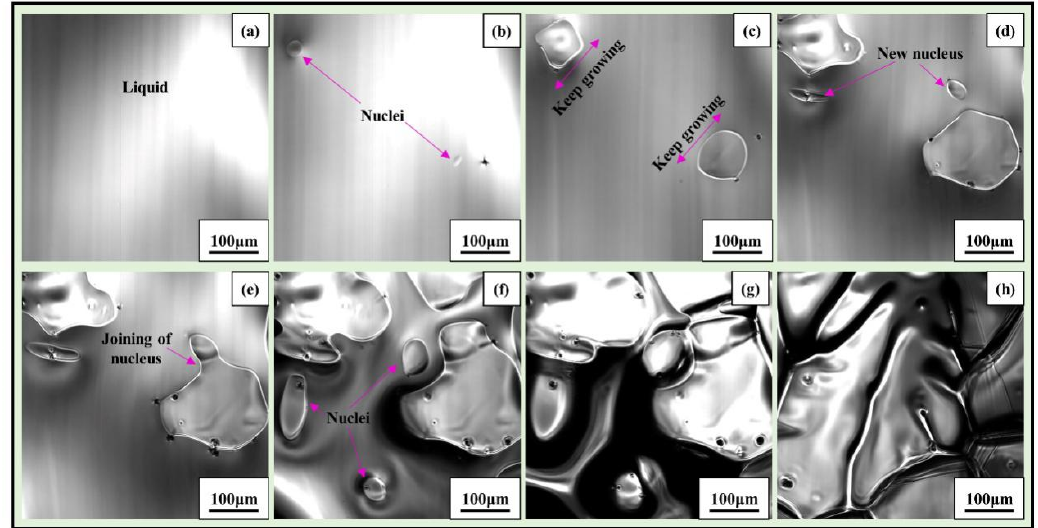
Figure 4. The microstructural evolution of the studied 70 steel upon the cooling processes by HT-CSLM: ( a ) 1493 °C; ( b ) 1473 °C; ( c ) 1469 °C; ( d ) 1462 °C; ( e ) 1457 °C; ( f ) 1442 °C; ( g ) 1431 °C; ( h ) 1417 °C.